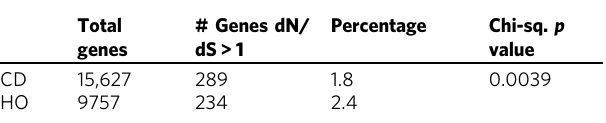
Table 1 Positive selection acts on a higher percentage of head-on